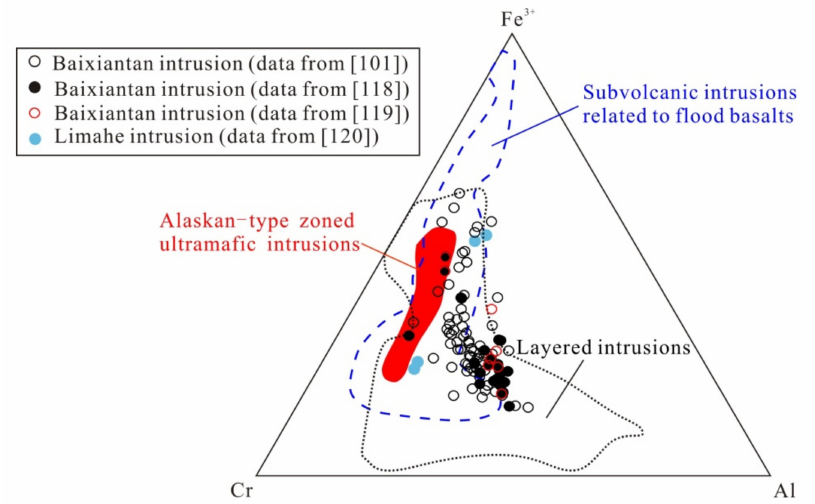
Figure 13. Trivalent ion plots for the Baixintan and Limahe intrusions [117]. Data sources of Baixintan: [101,118,119]; data source of Limahe: